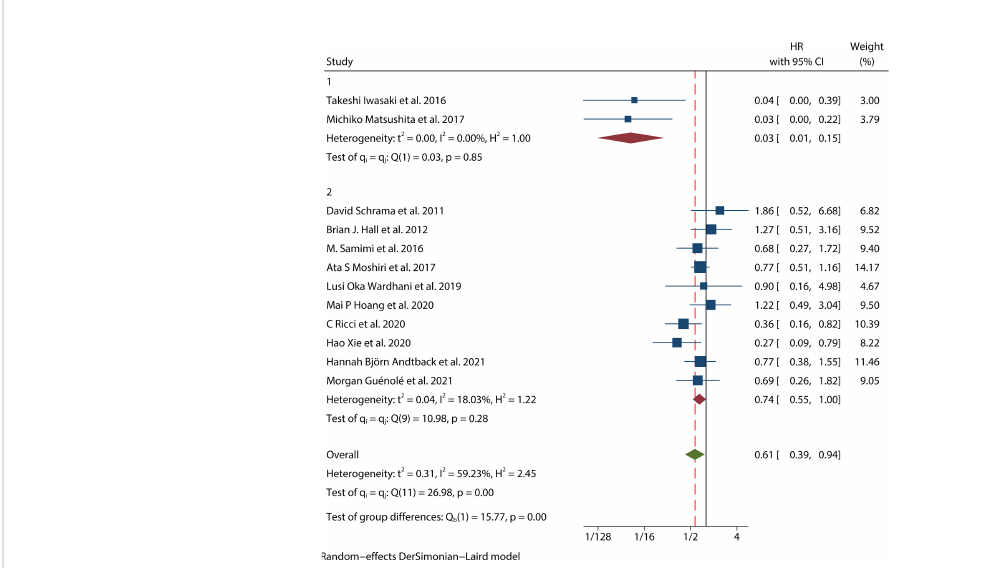
FIGURE 8 Sensitivity analysis of the association between MCPyV positivity and overall survival.